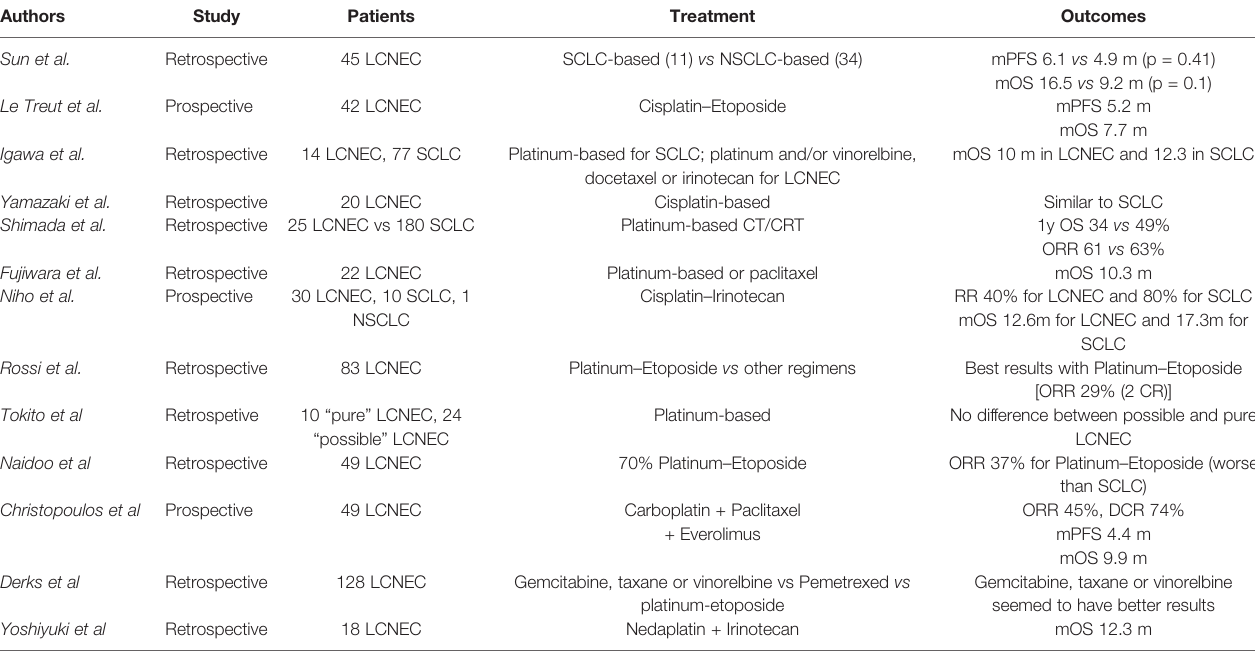
TABLE 3 | Antineoplastic therapies in the fi rst-line